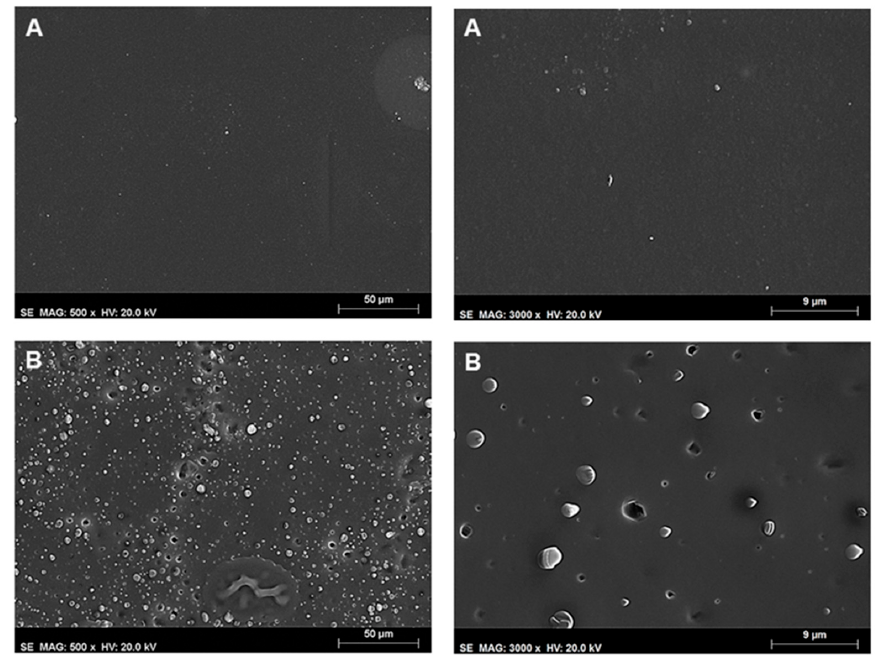
Figure 9. SEM images of ethyl cellulose films containing ( A ) F8T2 and ( B ) F8T2 and 1% PEG 600. The scale bars are 50 µm and 9 µm.